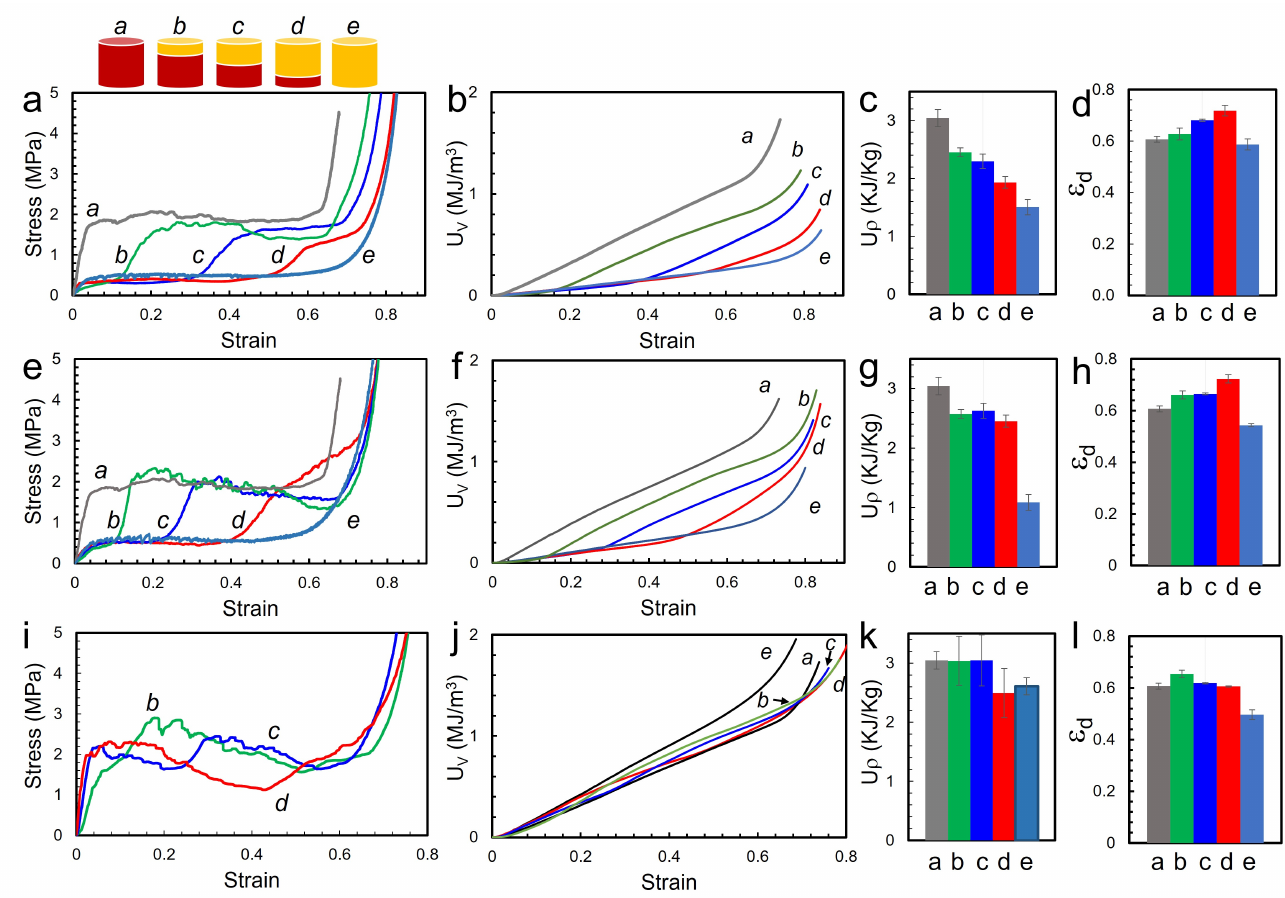
Figure 3. GF1 and GF4: ( a ) stress–strain curve ( b ) cumulative energy absorption, U V ( c ) specific energy absorption, U ρ ( d ) densification strain, (cid:101) d ; GF2 and GF4: ( e ) Stress–strain curve ( f ) cumulative energy absorption, U V ( g ) specific energy absorption, U ρ ( h ) densification strain, (cid:101) d ; GF3 and GF4: ( i ) Stress–strain curve ( j ) cumulative energy absorption, U V ( k ) specific energy absorption, U ρ ( l ) densification strain, (cid:101) d